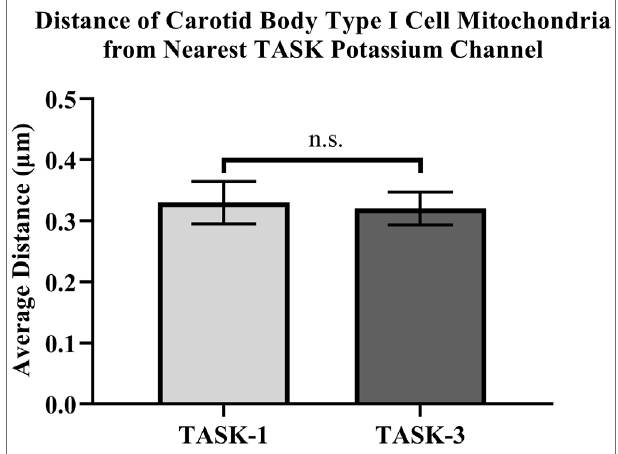
FIGURE 3 | Distances between antibody-labeled (TOMM20) mitochondria and TASK-potassium channels in rat Carotid Body Type I cells were measured using confocal microscopy. Microdomains were found between mitochondriaand TASK-1: 0.33 ± 0.04 µm (n= 47) and TASK- 3 potassium channels: 0.32 ± 0.03 µm (n =